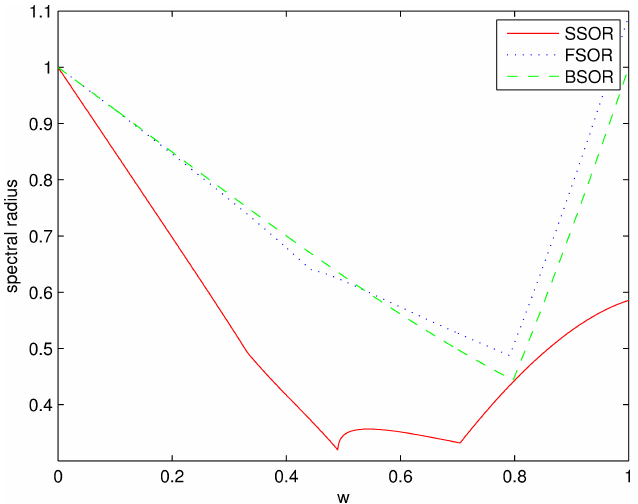
Fig. 2. The change of spectral radii of FSOR-, BSOR- and SSOR-iterative matrices with different